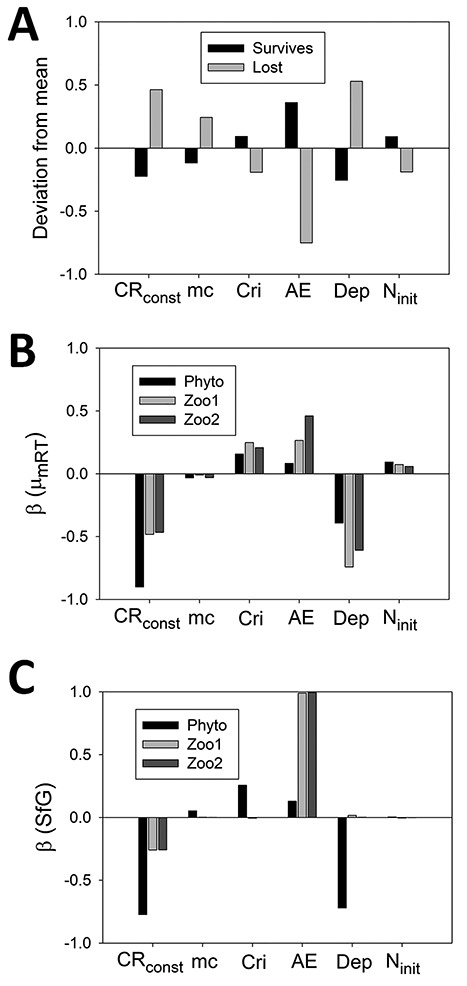
Regression statistics for NPZZ model. Detailed analysis of results from 200 simulations run to equilibrium over 2000 days (see also the summary in Fig. 8). The parameters shown along the X- axis are catabolic respiration constant (CRconst; dimensionless), mortality coefficient (mc; d−1), prey capture rate (Cri; gN gN−1 d−1), AE(dimensionless), mixed layer water depth (Dep; m) and initial and external N (Ninit; mgN m−3). Values for the parameters were distributed evenly in parameter space over the simulations (see Supplementary Table for parameter value ranges). Panel A: Mean parameter values, expressed as deviations from the overall mean in standard deviations, are shown for simulations where Zoo2 is lost (N = 65) and survives (N = 135). For panels B and C, the standardized β values from regression analysis for the simulations where Zoo2 survives (N = 135) are analogous to those for the Phyto chemostat in Fig. 4.